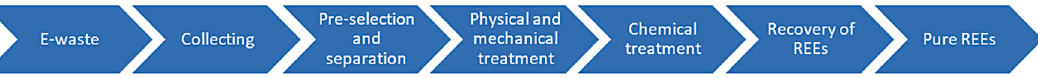
Figure 6. Steps of a general process of REEs recycling from e-waste.